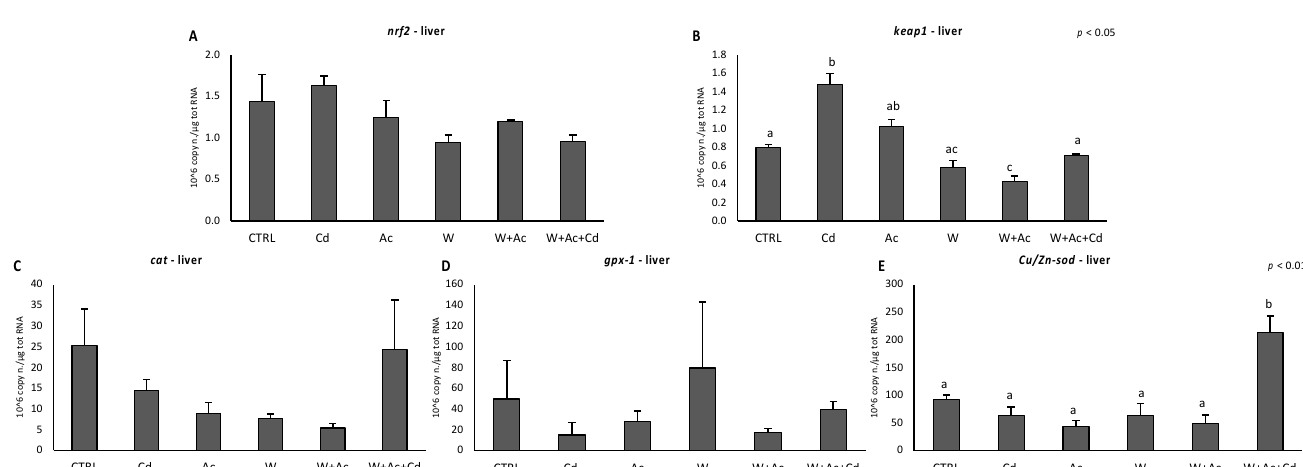
Figure 3. Transcriptional responses of antioxidant regulation system ( A , nrf2 ; B , keap1 ) and antioxidant enzymes ( C , cat ; D , gpx1 ; E , Cu/Zn-sod ) in liver of T. bernacchii . Different letters highlight significant differences between groups of means. Data are expressed as mean ± standard deviations, n = 5.